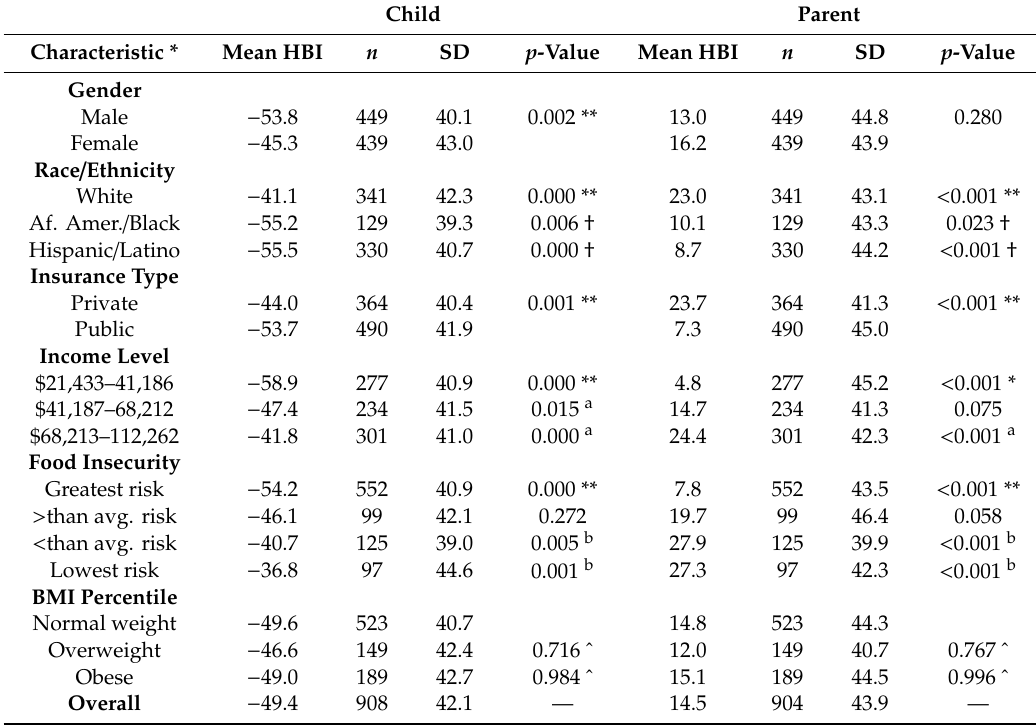
Table 5. Analysis of variance for mean child and parent Healthy Behavior Index (HBI) by child’s demographics, community food environment, and